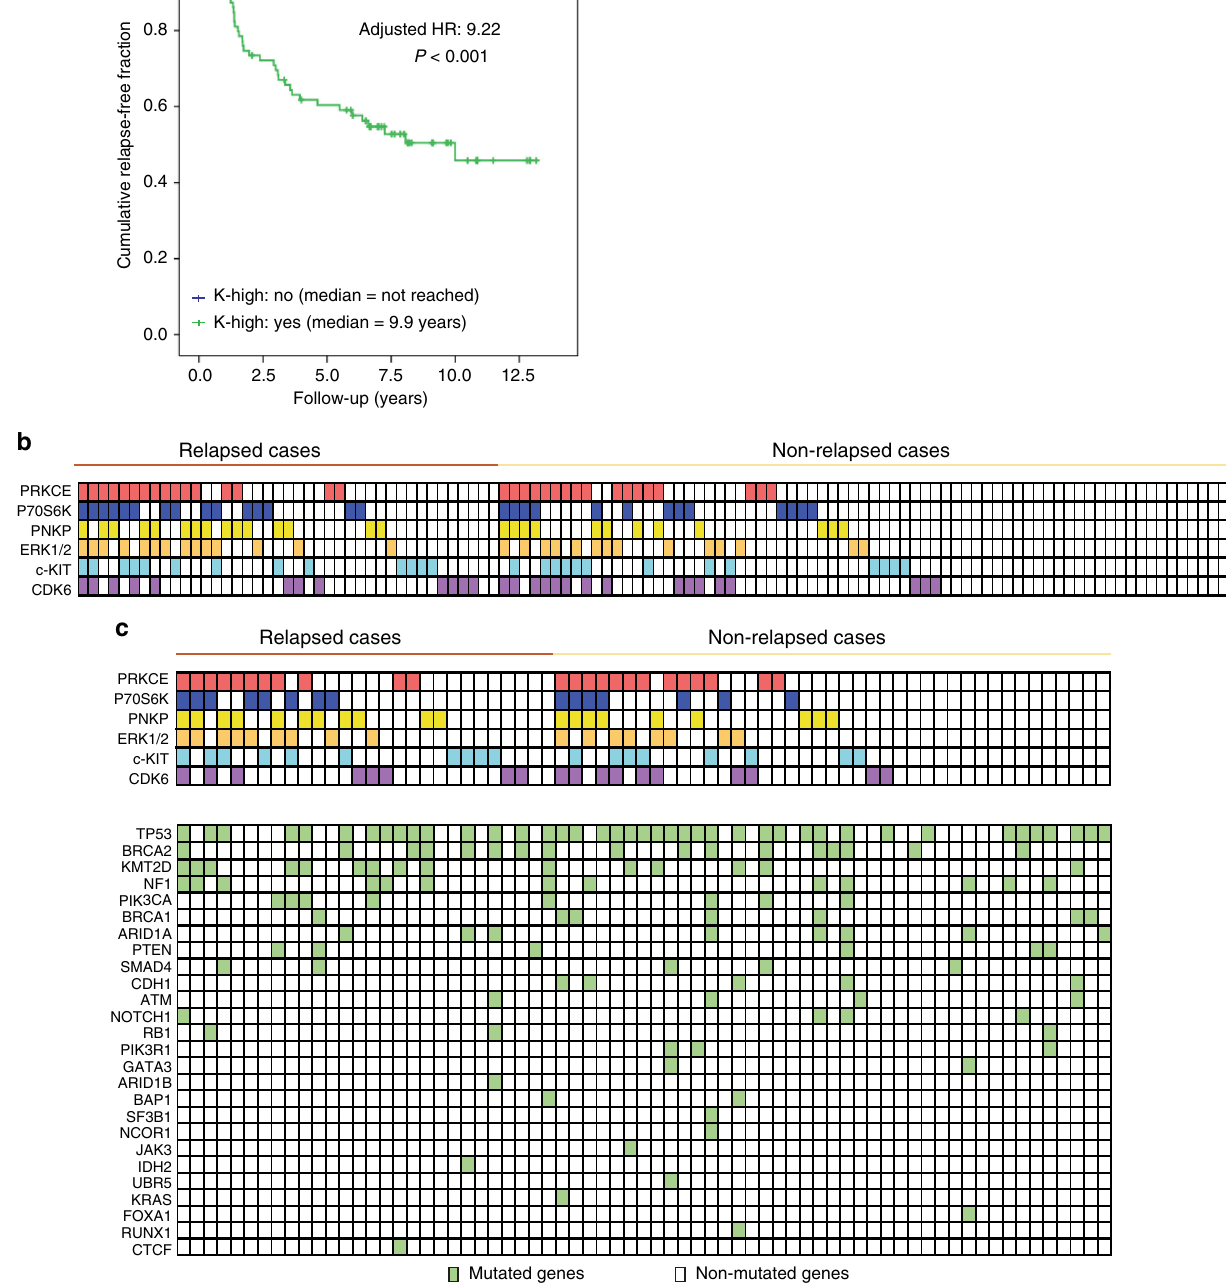
Fig. 4 Clinical implications of kinomic and genomic landscapes. a Prognostic impact of the presence of one or more activated kinases : Kaplan – Meier curve for relapse of patients in validation set Val-1, whose tumors showed high activity of any of the 6 kinases (green chart: K-high = yes) versus the remaining (patients who showed low activity of the 6 kinases; blue chart: K-high = no). b Each of the 6 kinases with prognostic power is listed on the left side (rows), and for each patient (columns, strati fi ed according to relapse status), the number of kinases with high-quartile staining are shown. c Below the kinase grid, a second grid contains the mutational status (yes/no, according to the fi lters explained in the Methods section) of the 25 most frequently mutated genes for each sequenced patient. The data show the “ collapse ” of mutational patterns into kinomic patterns; for instance, pattern 38 (Supplementary Table 5) was observed in patients both with and without TP53, BRCA2, PTEN, or ARID1A mutations. The same statement was also valid for other frequently observed kinase patterns in the validation set, such as c-Kit-high (pattern 36 ( N = 9 patients), which accounted for patients with various combinations of wild-type and mutant TP53, BRCA2, PIK3CA, and PTEN) or